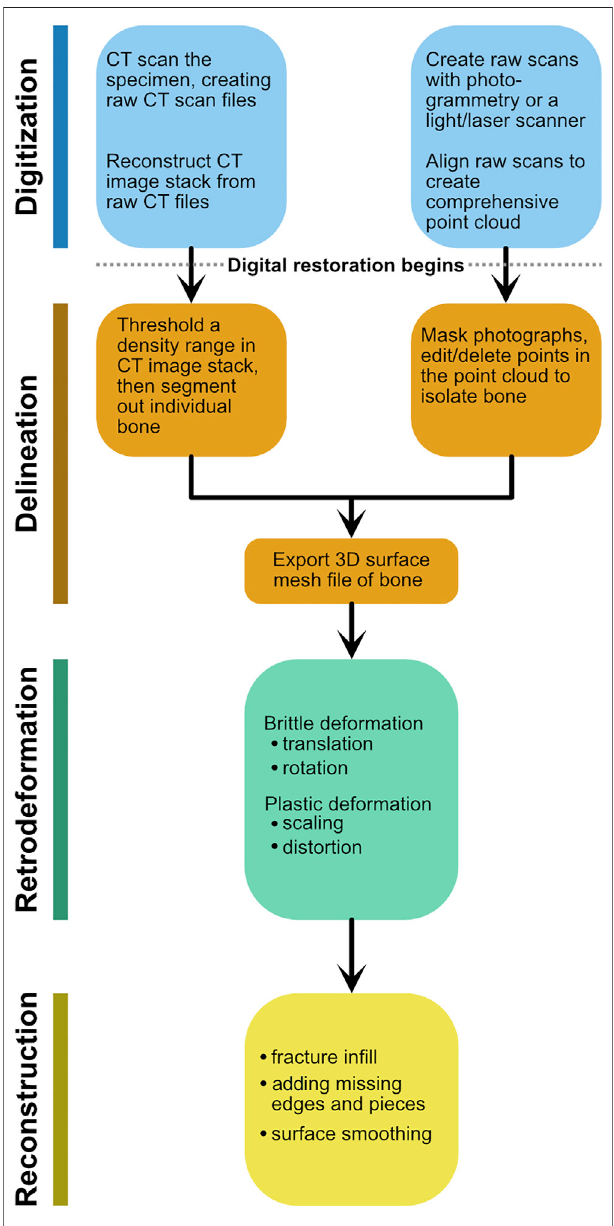
FIGURE 1 | Schematic fl owchart detailing the stages of digital restoration using the terminology from Table 1 . Either entry point for digitization generates a 3D surface mesh, which then is subject to retrodeformation and reconstruction.